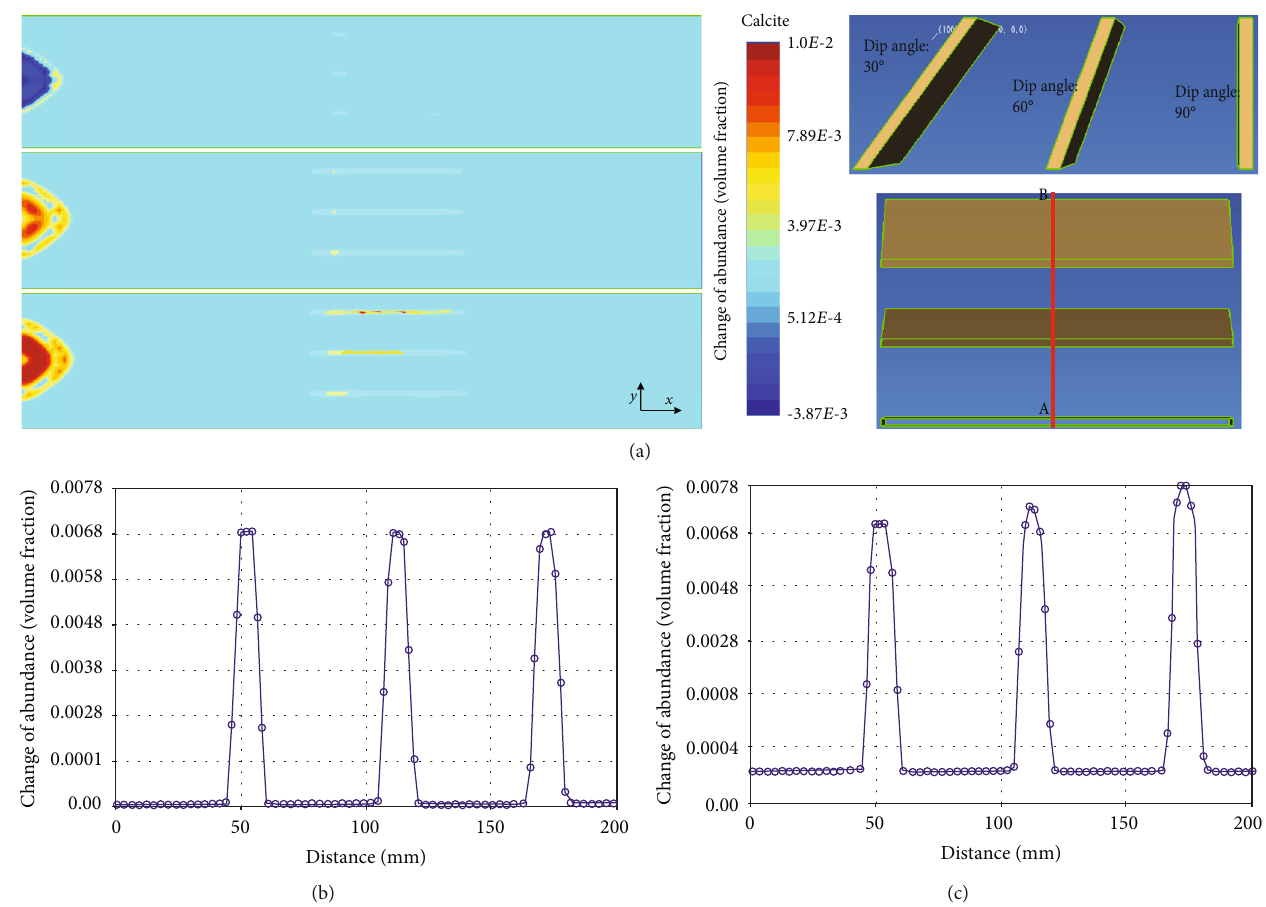
Figure 7: Spatial distribution of geo fl uid fl ow and calcite abundance during simulations of fractures with di ff erent dip angles (negative values indicate dissolution and positive precipitation). (a) Changes of calcite abundance in cross section during fl uid injection; (b) changes of calcite abundance of vertical fracture deposition for 200 years; (c) changes of calcite abundance of low-angle fracture deposition for 200